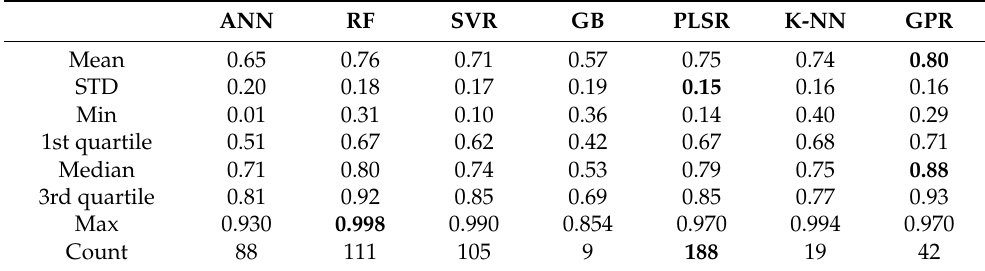
Table 5. Statistical analysis of R 2 in various non-parametric algorithms.